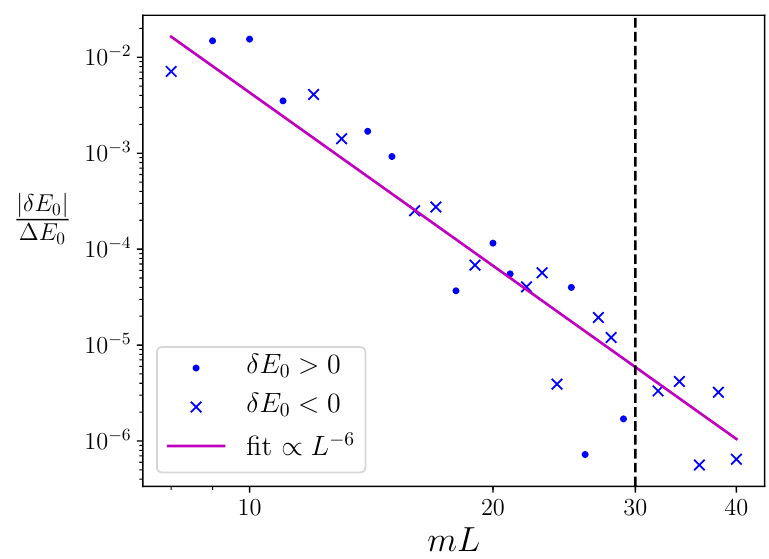
Figure 14 . I PV -dependence of the ground-state energy E 0 ( L ), with (cid:14)E 0 de(cid:12)ned in eq. (A.3). We plot the ratio to (cid:1) E 0 = E 0 (cid:0) 3 m in order to give a sense of the relative size of the shift. The vertical line at mL = 30 indicates the point at which matching is performed, so that (cid:14)E 0